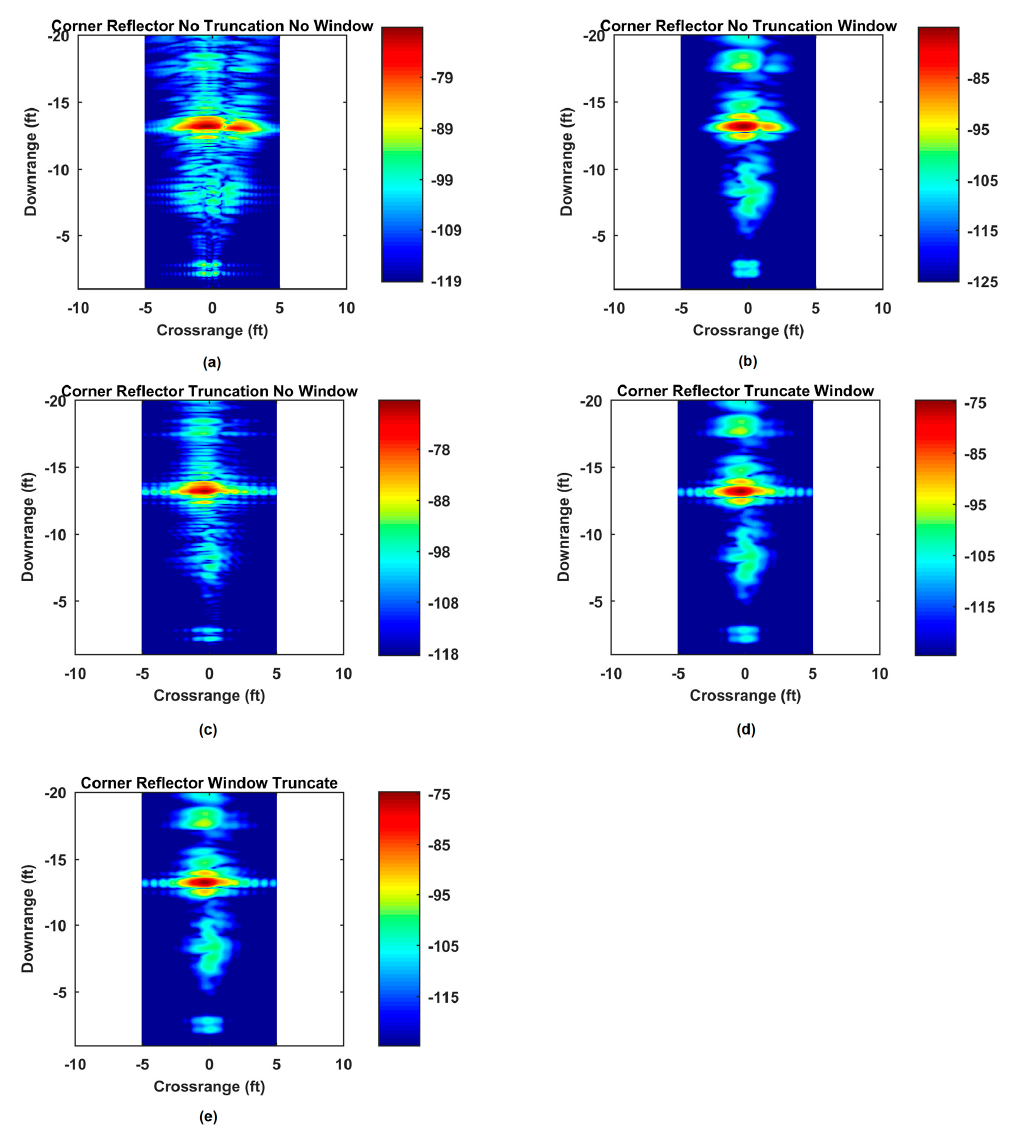
Figure 6. Images of corner reflector through wall at 3.96 m (13 feet) with varying window and truncation application: ( a ) No truncation, no window; ( b ) No truncation, with window; ( c ) Truncation, no window; ( d ) Truncation first, then window; ( e ) Window first, then truncation.